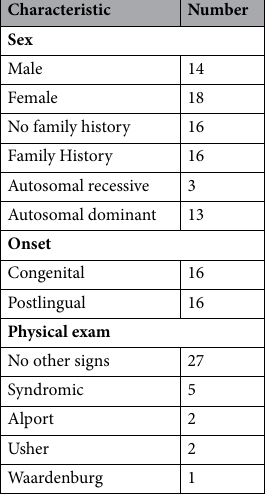
Table.1. Reported phenotype characteristics of the 32 patients evaluated in this